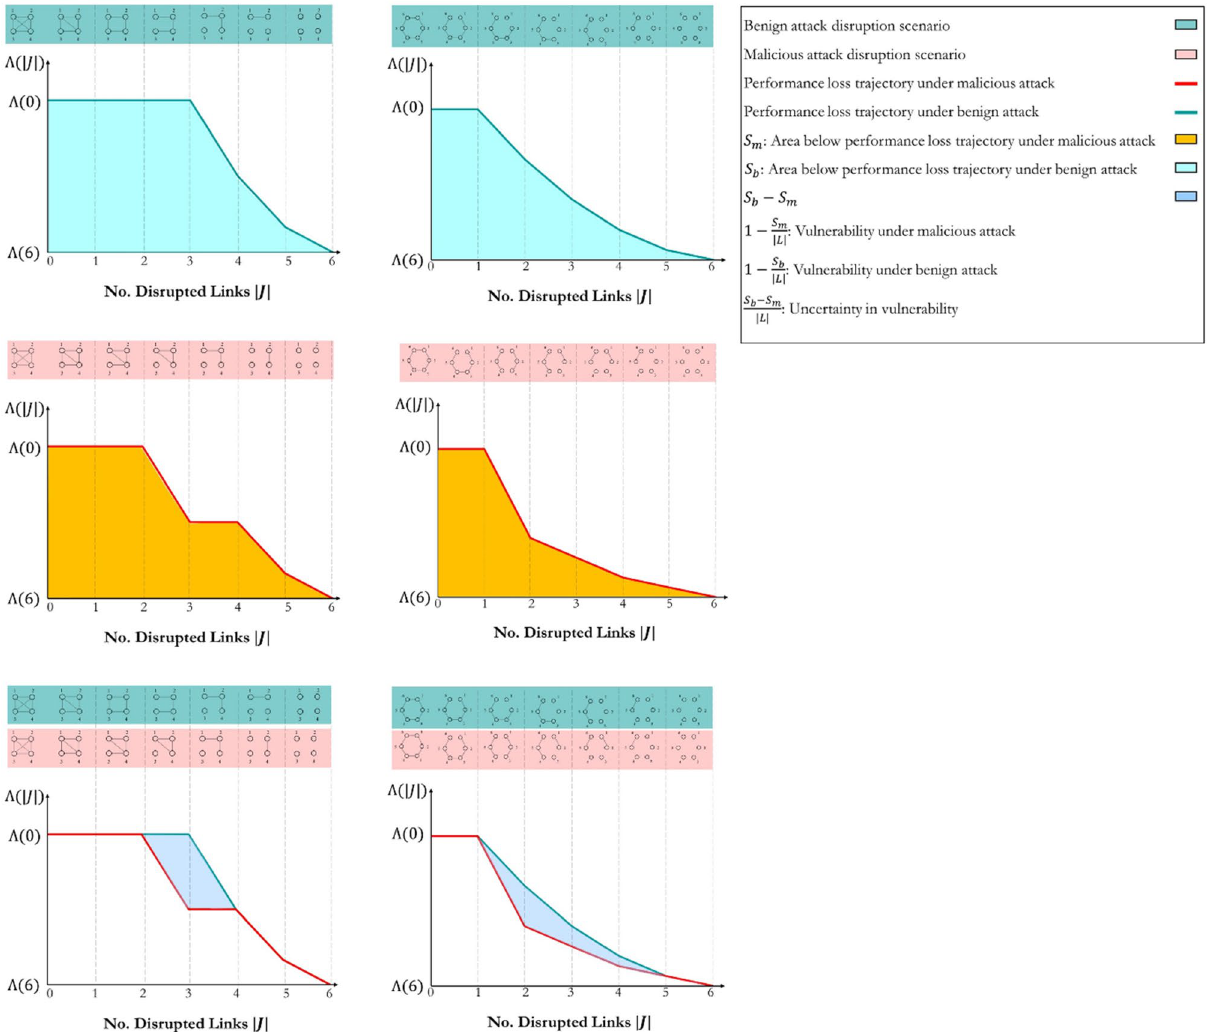
Figure 1. Performance loss trajectory of the ring and complete networks with six links. The figure represents the interdependencies among the network topology, redundancy level, and the delay in the network performance loss trajectory. Considering complete network topology, the disruption of three links ( | J | = 3 ) does not change the performance of the networks from their original performance and ϕ | L |−| J | = ϕ | L | . We draw a similar conclusion for ring network topology with the disruption of one